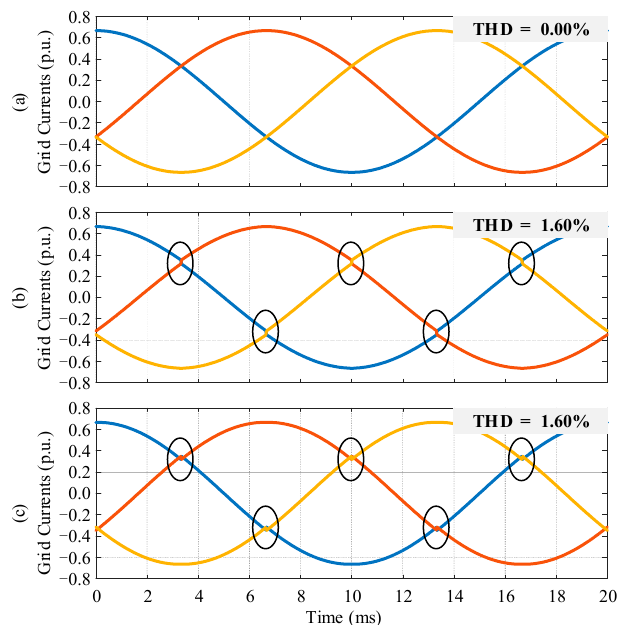
Figure 6. Grid currents considering the inaccurate reference of injected harmonic current: ( a ) 0% inaccuracy; ( b ) − 0.5% inaccuracy; and ( c ) 0.5% inaccuracy. Distortion is indicated with circles.